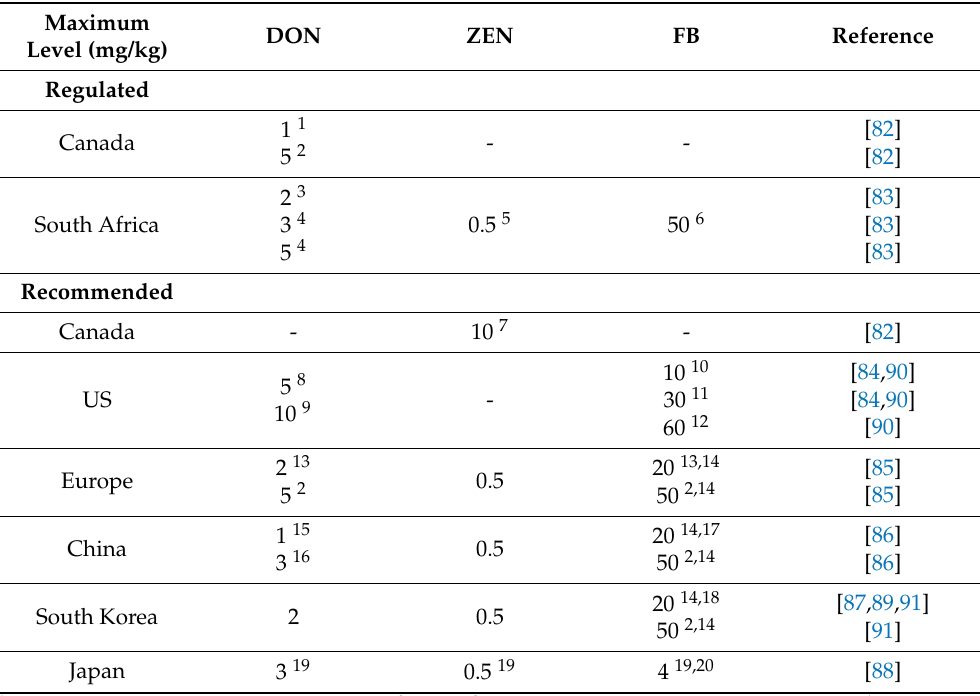
Table 1. Regulated and recommended levels of Fusarium toxins in the final diet of